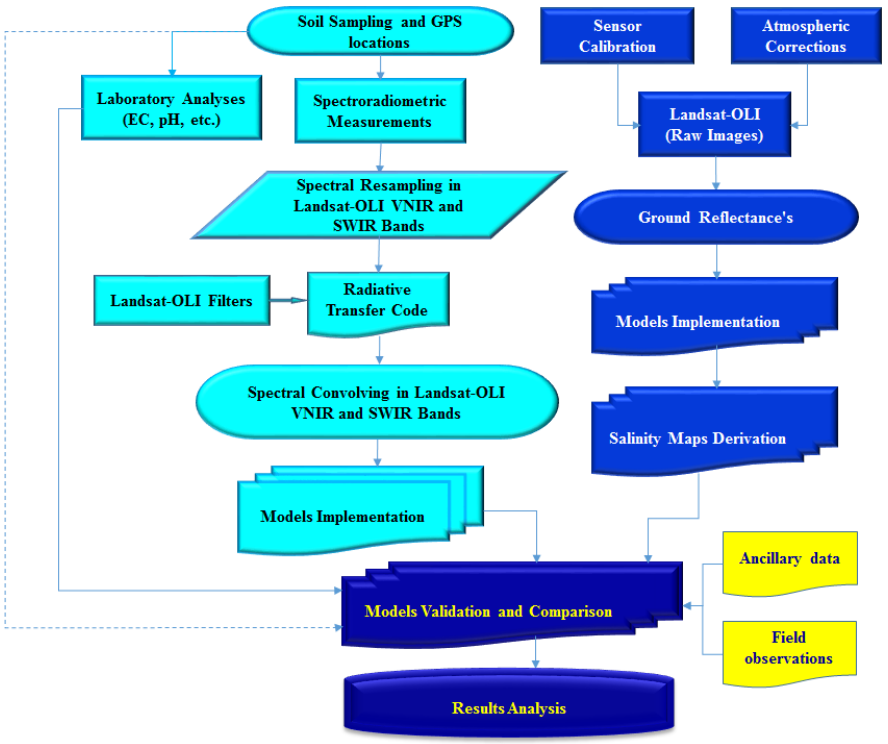
Figure 1. Methodology Flowchart.